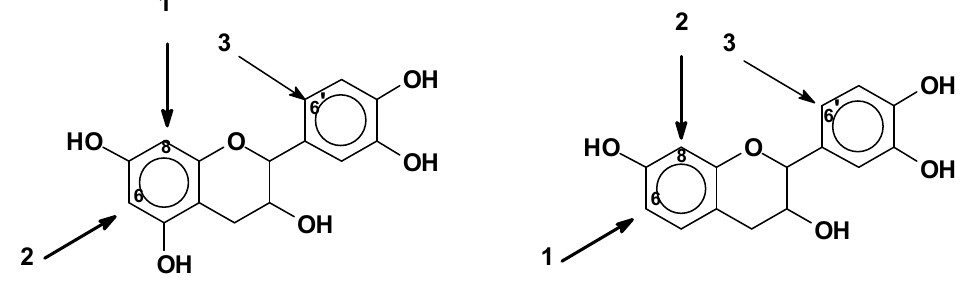
Figure 8. Reactive sites of flavonoid units.